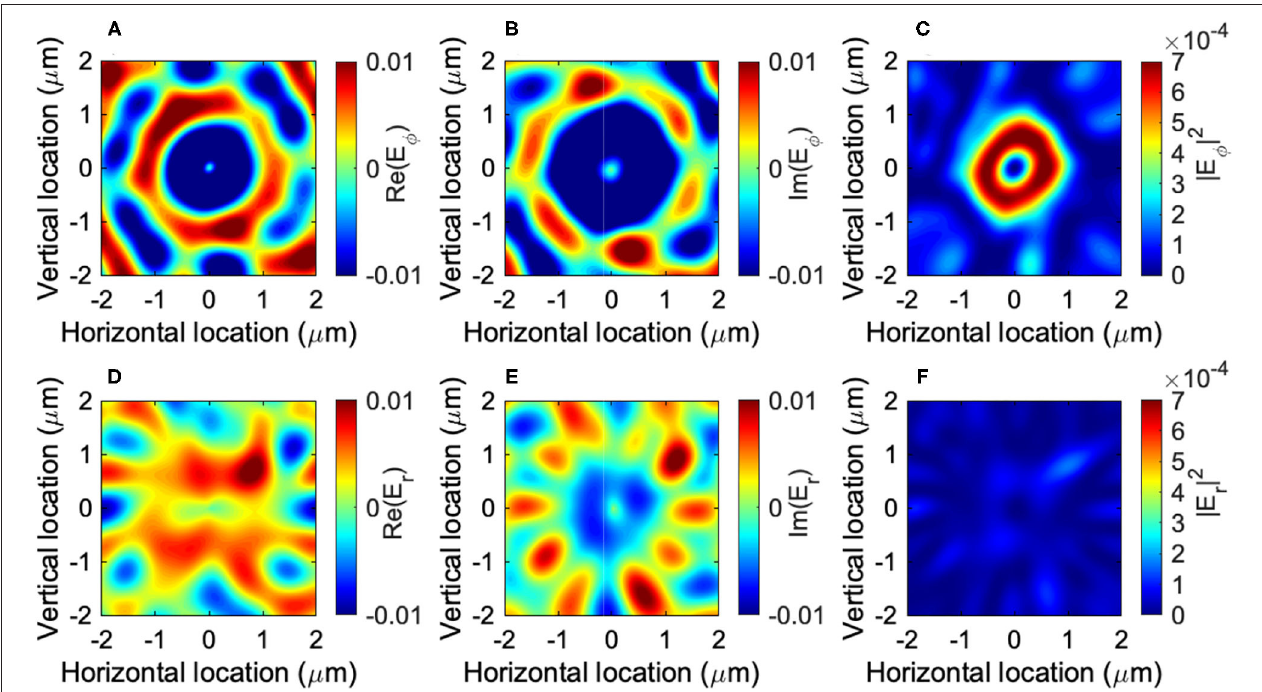
FIGURE 9 | Left vortex generated from the gear of N 10. The input port 1 is used to inject photons to the waveguide, and the mode profile is obtained at z = above the gear. (A) Real part, (B) imaginary part, and (C) intensity of the azimuthal complex electric field ( E φ ). (D) Real part, (E) imaginary part, and (F) intensity of the radial complex electric field ( E r ). E φ is almost constant over the ring, such that the mode is dominated by the azimuthal component.